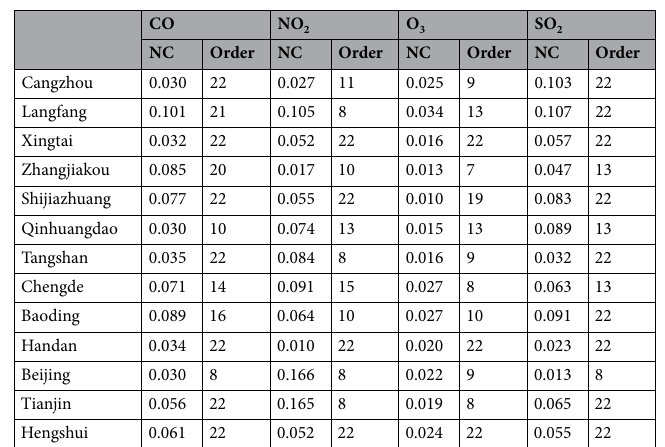
Table 1. NC results of the pollutants to PM 2.5 concentrations inside each city.